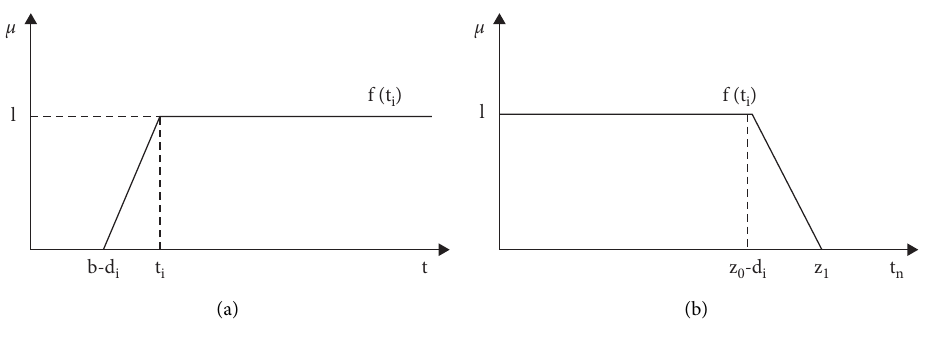
Figure 2: Function image: (a) f ( t